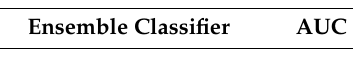
Table 9. AUC evaluation of ensemble with RF base classifier.